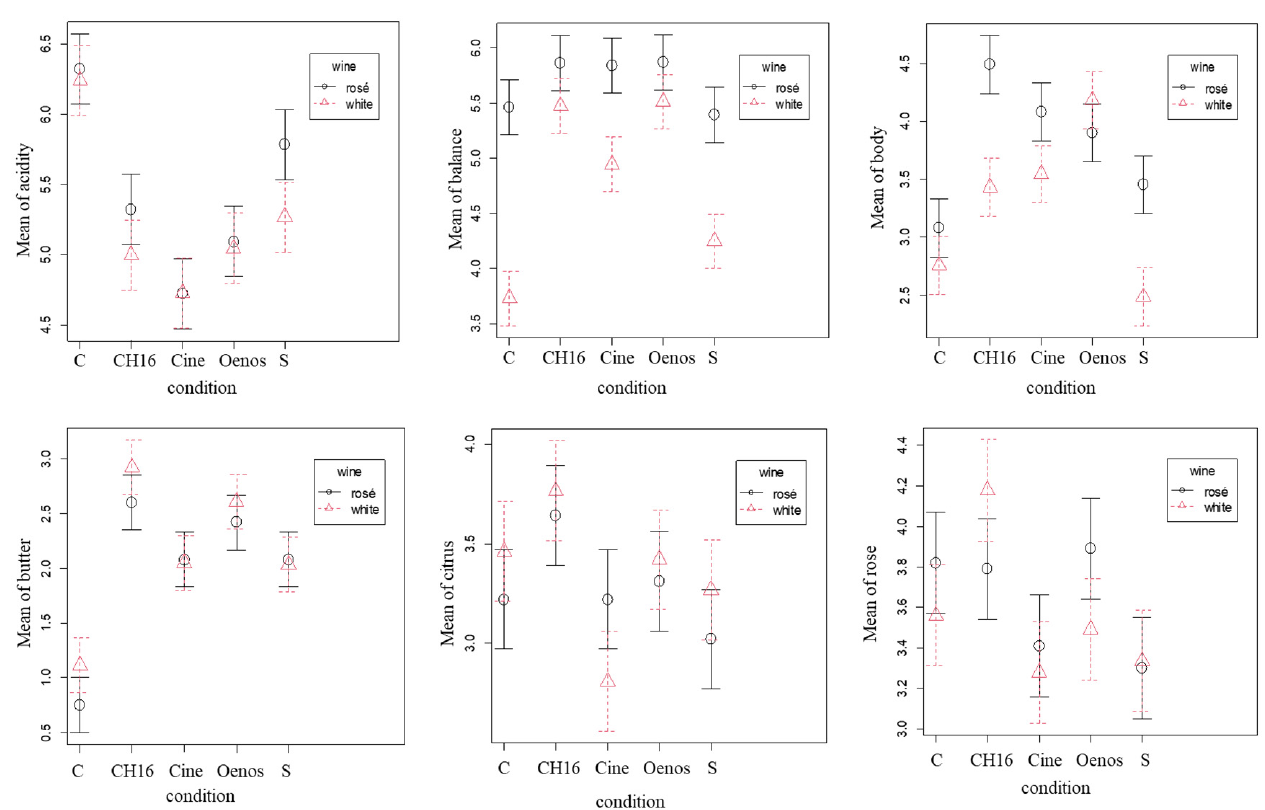
Figure 2. Interaction plot of the means of the sensory descriptors (acidity, balance, body, butter, citrus, rose) taken versus the malolactic fermentation scheme for Moschofilero rosé and white wines. The O. oeni strains used to realize the malolactic fermentation were Viniflora ® CH16 (CH16), Viniflora ® Oenos (Oenos) and Viniflora ® CiNe (Cine). Spontaneous fermentation is denoted by (S) and wines in which no MLF took place are denoted by (C). Error bars indicate the standard error of the mean values.